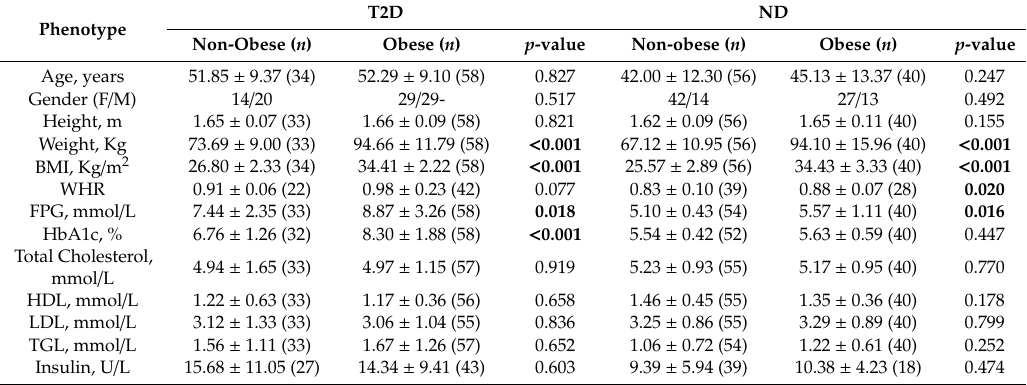
Table 2. Sub-analysis of demographic and baseline characteristics based on obesity